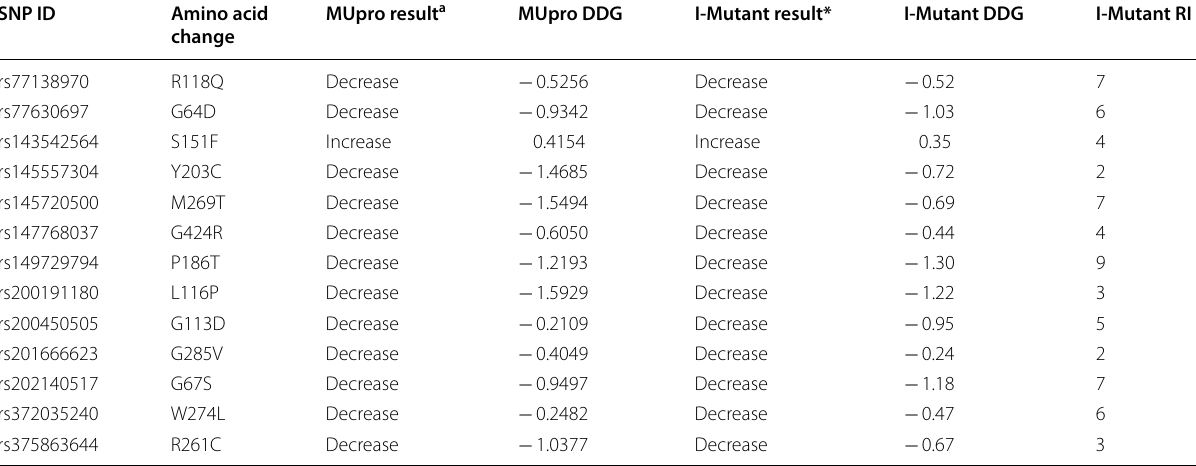
a Protein stability: Increase or decrease; DDG values are calculated